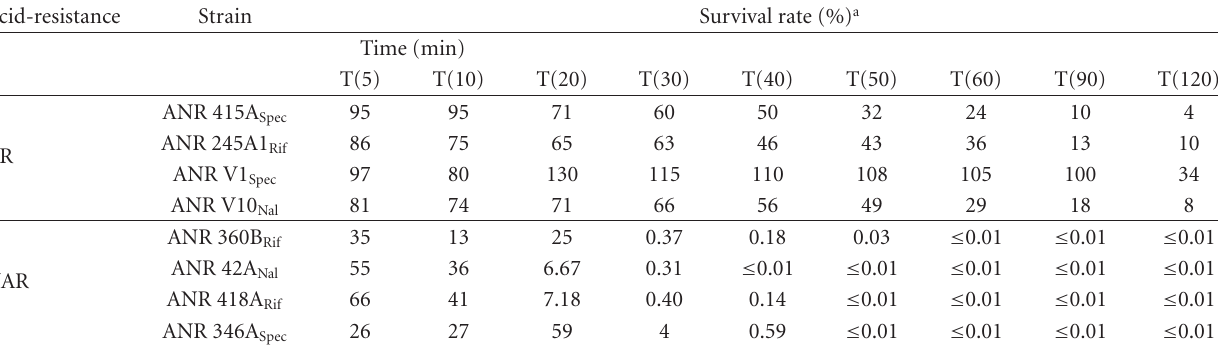
Table 5: Survival rates of STEC strains in simulated gastric fluid at pH: 2.